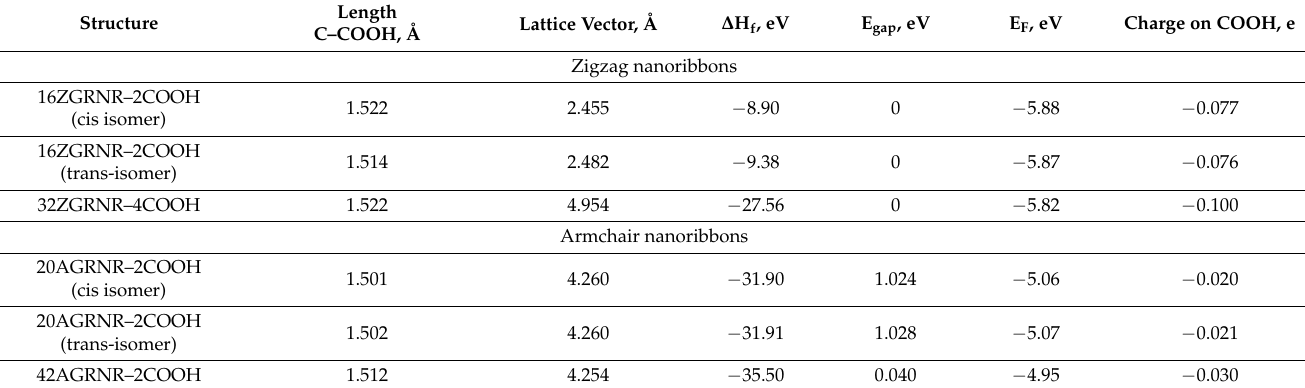
Figure 1. Atomistic models of carboxylated graphene nanoribbons: ( a ) zigzag nanoribbon; ( b ) armchair nanoribbon (carboxyl groups in the figure are circled in green). Table 1. Metric and energy characteristics of carboxylated graphene nanoribbons.